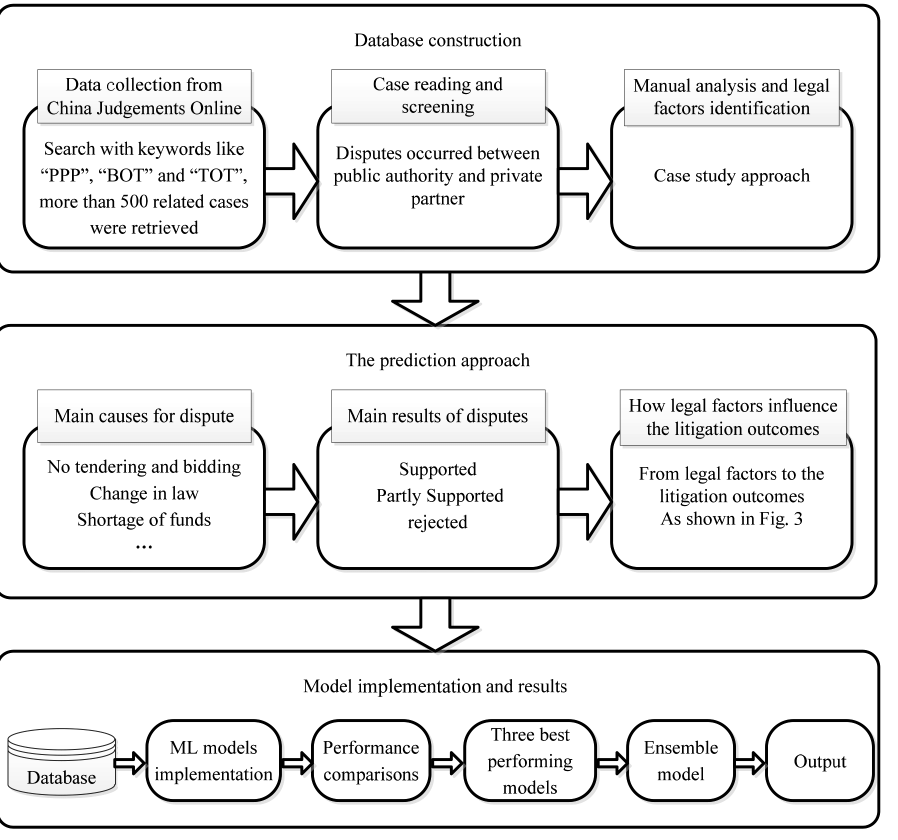
Figure 1. Research